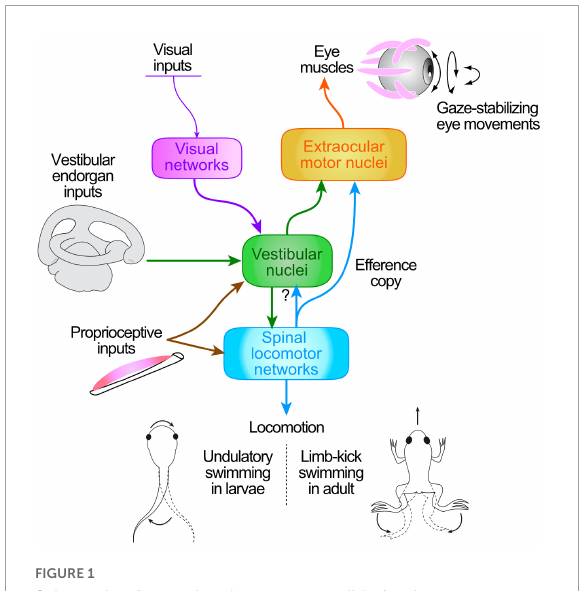
FIGURE1 Schematic of central pathways responsible for the transformation of head/body motion-related sensory signals (from visual motion, vestibular endorgans, neck proprioceptors) and ascending motor efference copies (ECs) from spinal locomotor CPG networks into ocular motor commands for gaze stabilization during tail undulatory swimming in Xenopus larvae (bottom left) and limb-kicking propulsion in adults (bottom right)